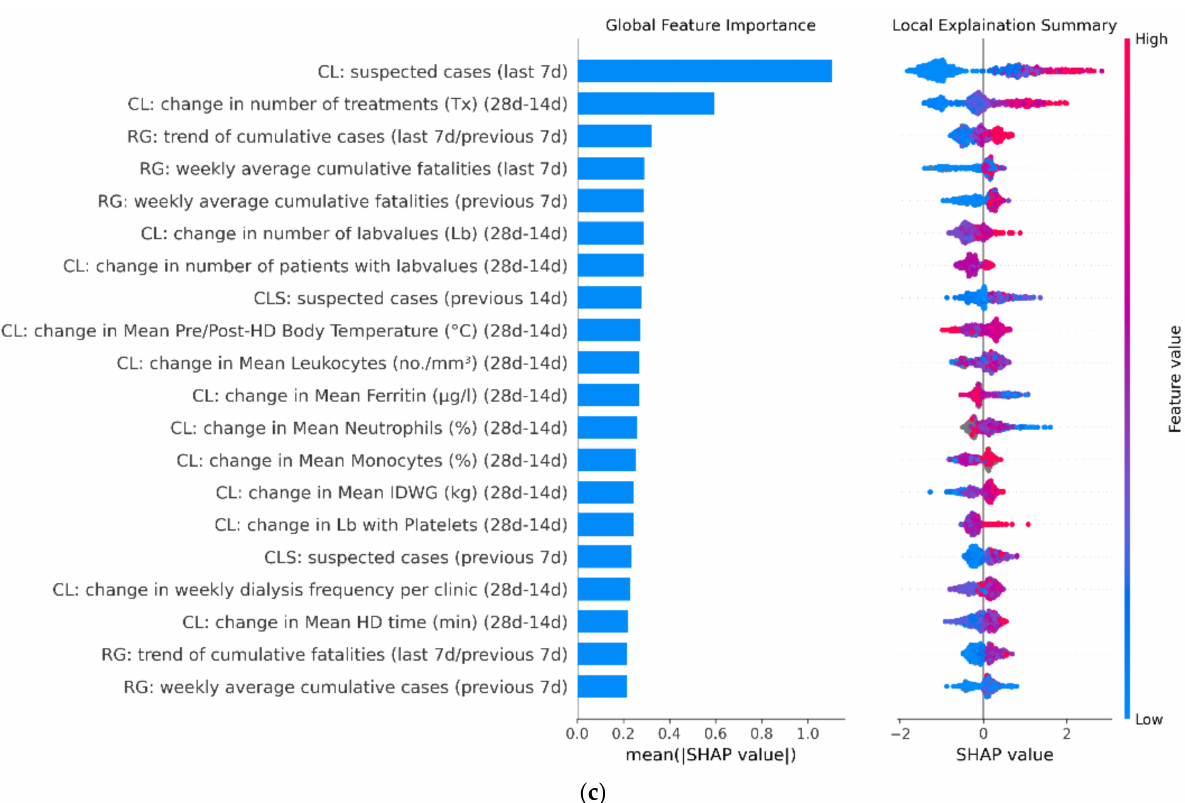
Figure 6. Panel ( a – c ) respectively contain the Shapley additive explanations (SHAP) related to Model 1, Model 2, and Model 3 evaluated on the following dates: 15 April 2020, 1 August 2020, and 15 November 2020. SHAP plots show relative feature importance. The blue bar represents overall SHAP values for each variable and are interpreted as relative importance of each variable to risk estimates. On the right side, SHAP values show the direction of association between predictor and risk estimates. Each dot represents one individual clinic from the test dataset. Higher values of the predictors are represented in red color; lower values of the predictors are represented in blue color. The X axis represents the impact of variables on risk in terms of SHAP values. Red color in correspondence with positive values suggests direct correlations between risk factors and the occurrence of COVID-19 outbreak, while red color in the region of negative SHAP values suggests inverse